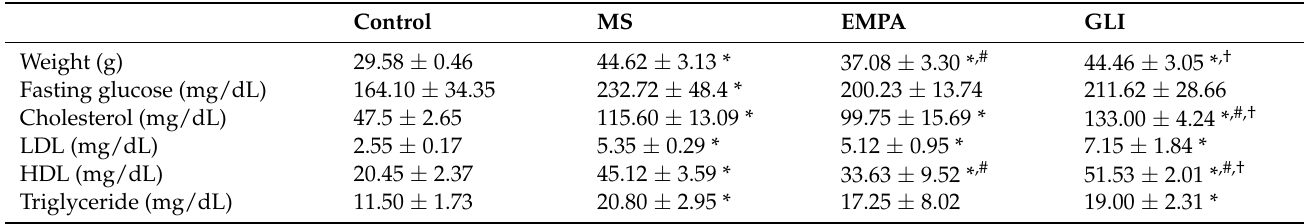
Table 1. Characteristics of the study groups after 16 weeks of feeding.